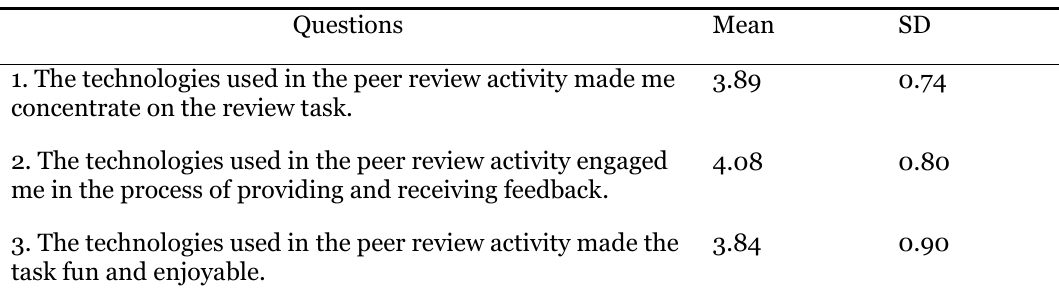
The Pre- Service Teachers’ Ratings of the Technology Integration in the Peer Review Activity